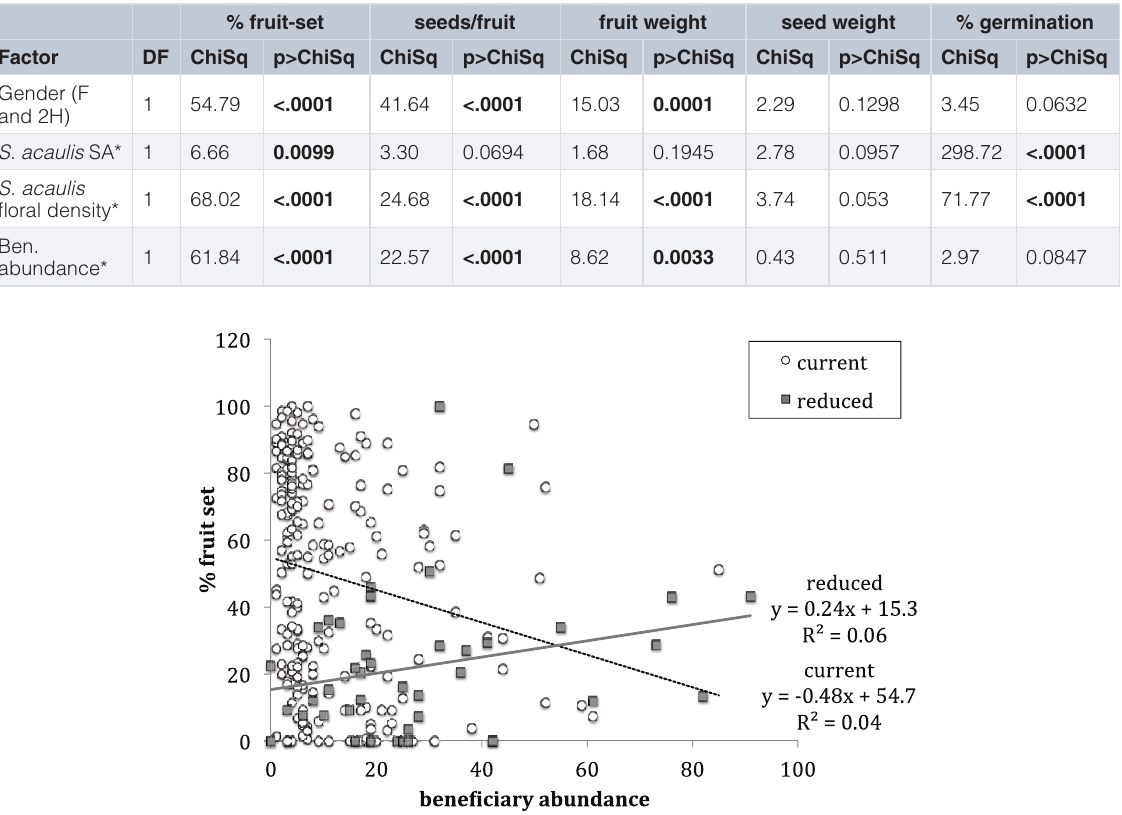
Figure 3. Percent fruit set and beneficiary abundance on individual S. acaulis plants under current pollination regime (white circles) and reduced pollination regime (grey squares). The linear best-fit line for plants under current pollination regime (black dashed line) has a negative slope of -0.48 and R 2 value of 0.04. The linear best-fit line for plants under reduced pollination regime (grey line) has a positive slope of 0.24 and R 2 value of 0.06. The slopes of these lines significantly differ (Chi 2 161.25, p-value